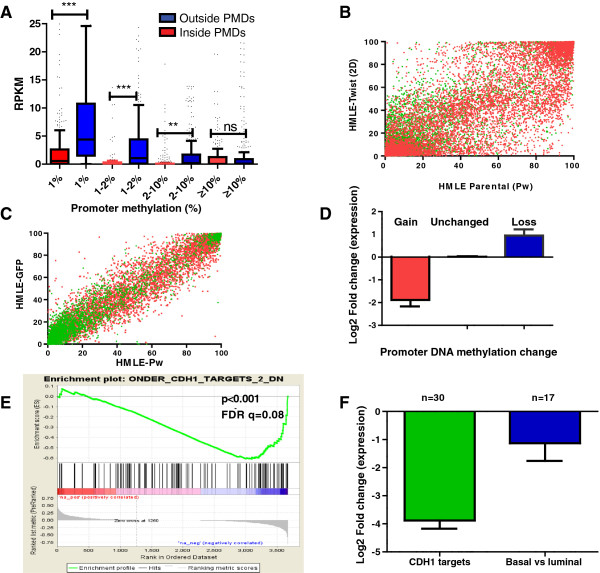
DNA Methylation changes occurring following epithelial-mesenchymal transition. (A) Box-plot for gene expression levels according to promoter DNA methylation level of genes located in partially methylated domains (PMDs) (red) and outside PMDs (blue) in human mammary epithelial cells (HMLE). The x-axis represents promoter % methylation and y-axis represents normalized expression level. *** P <0.0001, ** P <0.001, ns: non-significant. (B) Correlation of DNA methylation level of CpG sites in HMLE vector cells (Pw) (x-axis) and HMLE Twist cells (y-axis), showing dramatic changes in DNA methylation following EMT. (C) Correlation of DNA methylation level of CpG sites in HMLE vector cells transduced with two different ‘control’ vectors Pw (x-axis) and GFP (y-axis) showing no change in DNA methylation. (D) Box plots of average gene expression levels of genes with a gain, loss or no change in DNA methylation. Note that a gain of DNA methylation (increase to ≥2% DNA methylation from gene promoters which were fully unmethylated, ≤1%) was associated with 3.8-fold decrease of their expression levels, while demethylation of gene promoters leading to fully unmethylated promoters (≤1%) was associated with an increase in their gene expression levels by about 2-fold. (E) GSEA showing that genes losing gene body methylation following EMT are enriched for genes which are down-regulated in a CDH1-knockdown model of EMT (P <0.0001). The bottom graph represents the rank-ordered, non-redundant list of genes. Genes on the far right (blue) correlated most strongly with decreased gene expression in the CDH1-knockdown model of EMT. FDR, false discovery rate. (F) Box plots showing decreased expression levels of genes losing gene body methylation following Twist-induced EMT in two different models: knockdown of CDH1 and basal breast cancers compared to luminal breast cancers. y-axis represents the log2-fold change of gene expression.